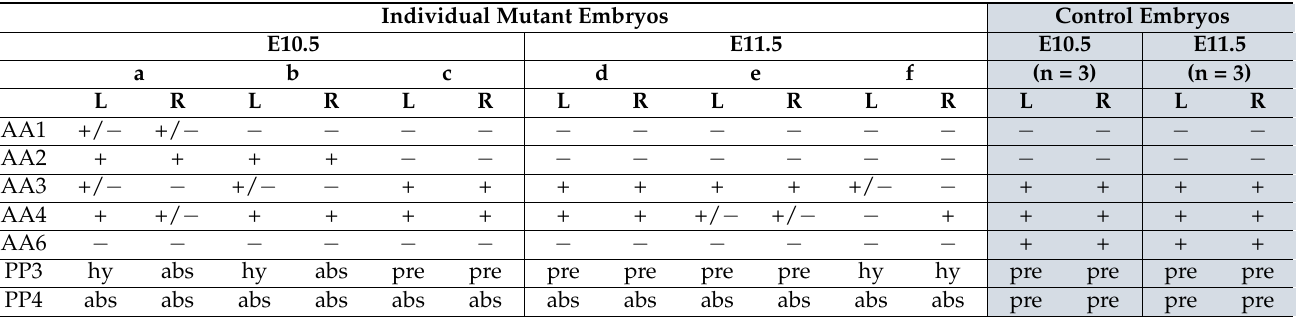
Table 2. Development of the aortic arches and pharyngeal pouches on the left and right sides (L and R) of individual Rarabg ∆ E9.5 mutants at E10.5 (a–c) and at E11.5 (d–f), and of control embryos. AA1 to AA6, aortic arches 1 to 6 (+: complete, the aortic arch connects the aortic sac to the dorsal aorta; − : absent; +/ − : missing dorsal part, the aortic arch is not connected to the aorta). PP3 and PP4, 3rd and 4th pharyngeal pouches (pre, present and of normal size; hy, hypoplastic; abs, absent). Individual Mutant Embryos Control Embryos